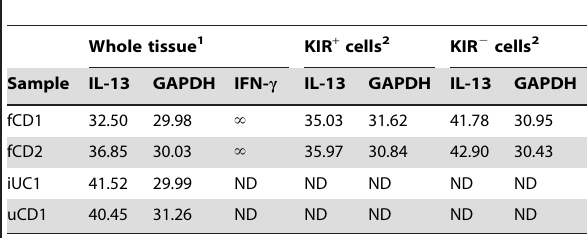
Table 1. KIR + cells in fibrotic muscle tissue synthesise